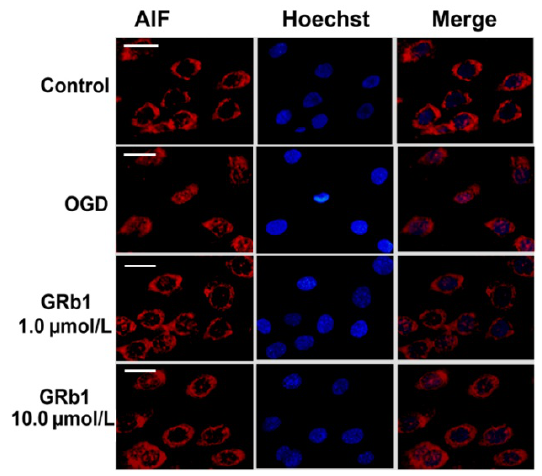
Figure 6. Immunocytochemical analysis of AIF redistribution.